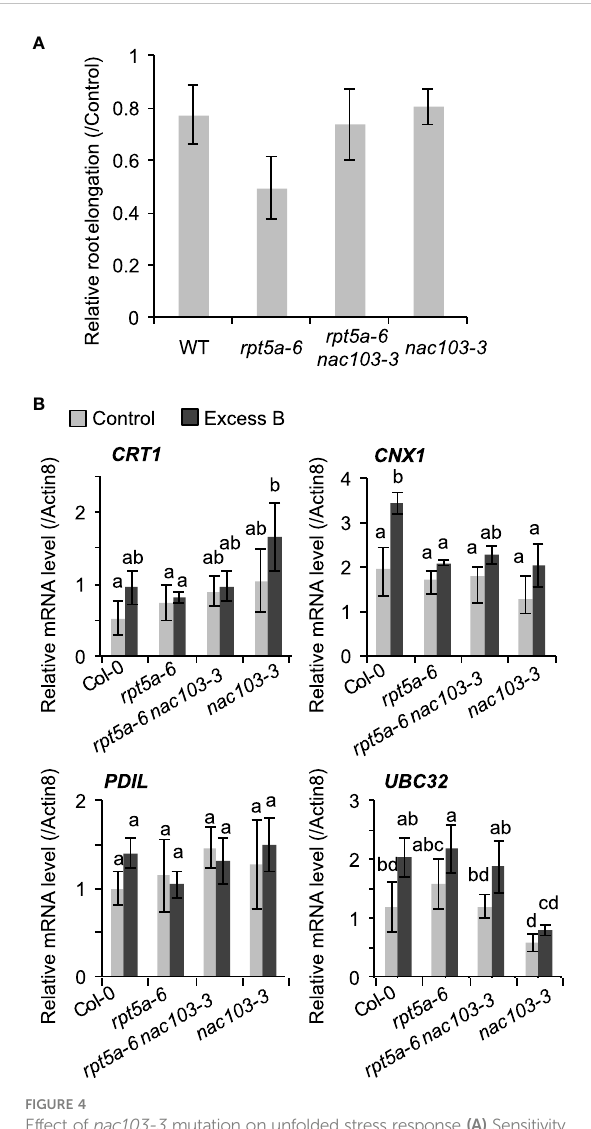
(Figure 5D). The comet assay revealed that DNA damage accumulation was signi fi cantly lower in the rpt5a-6 nac103-3 mutant than in the rpt5a-6 mutant, regardless of boron concentration. These results also reveal that the nac103-3 mutation ameliorated the extent of DNA damage in rpt5a-6 mutant plants.